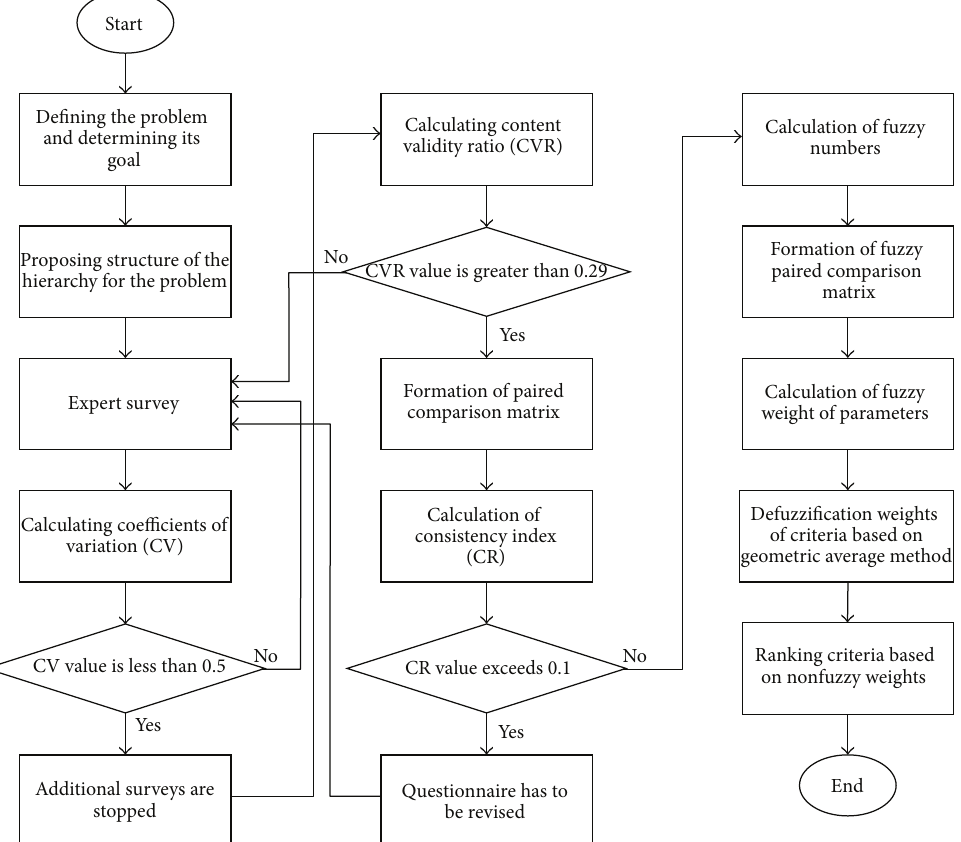
Figure 1: Flowchart of the proposed FDAHP